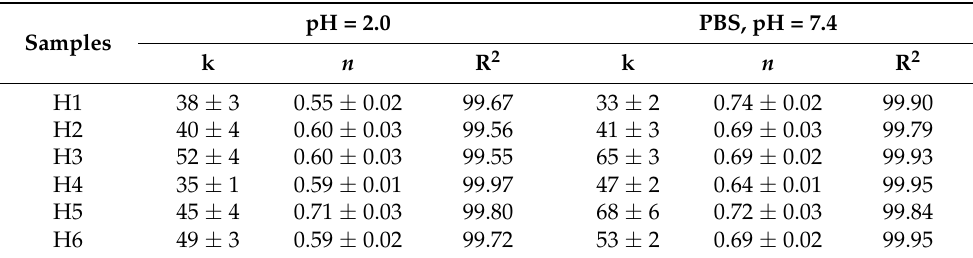
Table 1. Swelling kinetic constant (k), transport exponent ( n ), and coefficient of determination (R 2 ), according to Equation